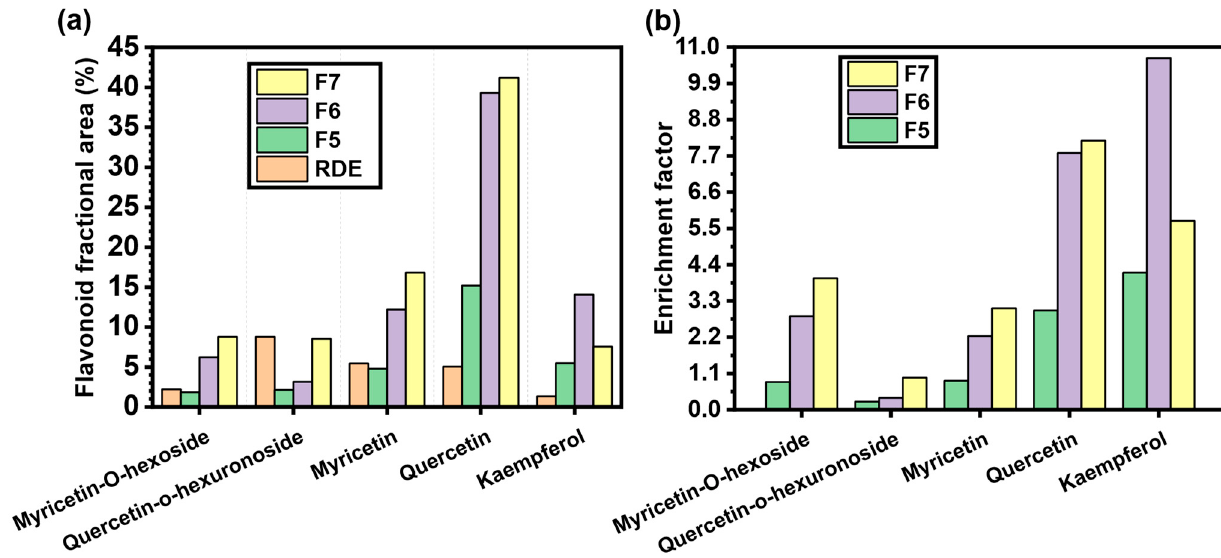
Figure 11. ( a ) Fractional area of each flavonoid identified in RDE and fractions 5, 6 and 7. ( b ) corre- sponding enrichment factors of these compounds.